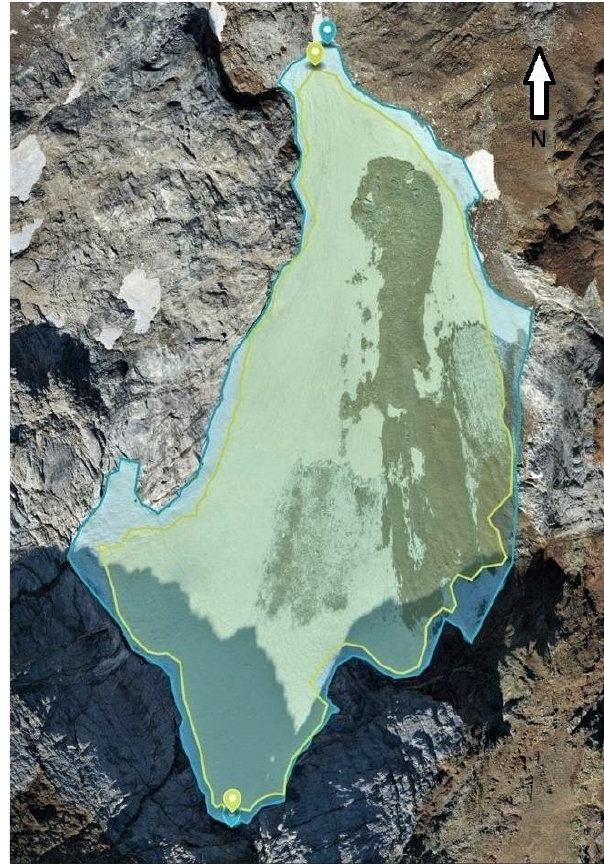
Figure 3. Drone photography of the Infierno Glacier, August 31, 2020, outline in blue. In yellow, outline of the glacier on August 30, 2022. Glacier head is at the bottom of the photo. Photo and composition by C. Martín.